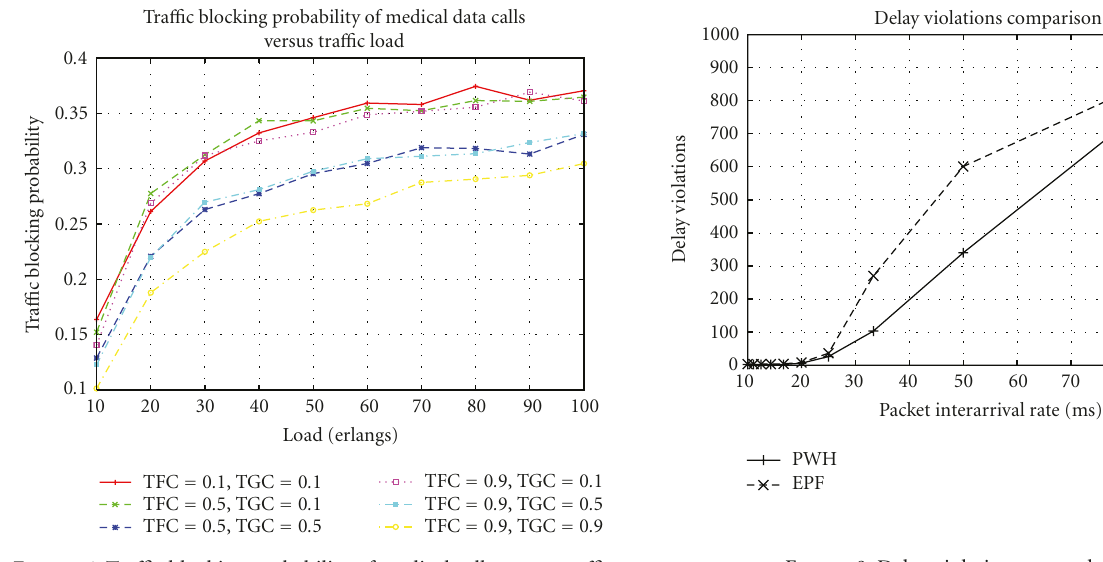
Figure 6: Tra ffi c blocking probability of medical calls versus tra ffi c load.